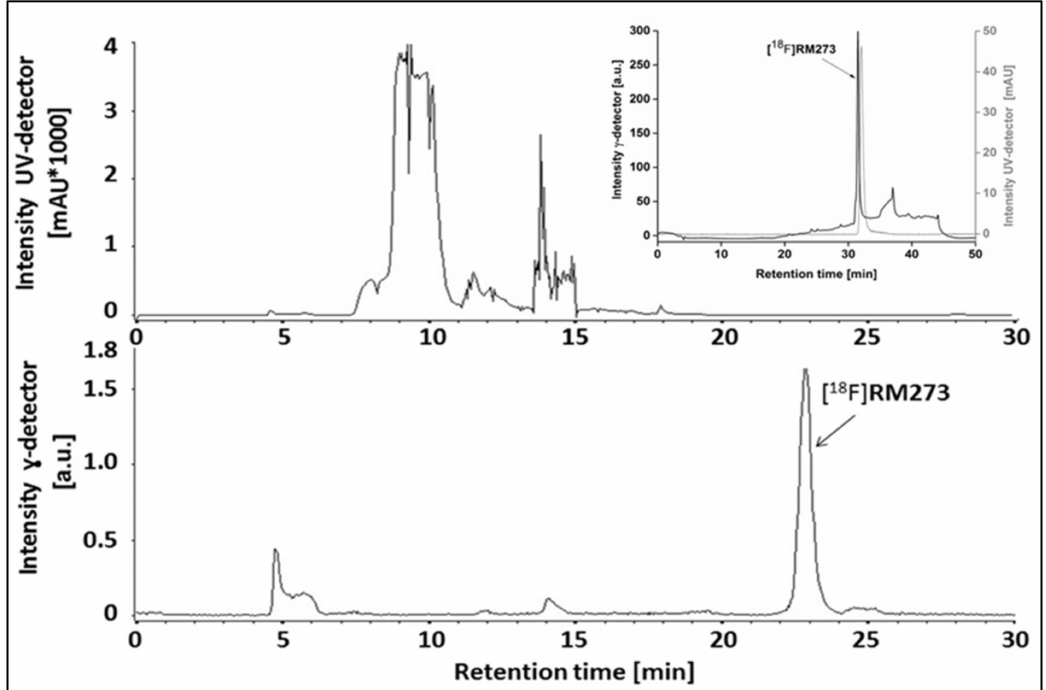
Figure 2. Representative radio- and UV-HPLC chromatograms of [ 18 F] RM273 isolated from the crude reaction mixture via semi-preparative HPLC (Reprosil-Pur C18-AQ column (250 × 10 mm, 5 µ m), 58% MeCN/20 mM NH 4 OAc aq. , flow: 2.2 mL/min), and, in the upper right corner, the radio- (black line) and UV- (gray line) HPLC chromatograms of the identity confirmation of [ 18 F] RM273 co-injected with the reference standard RM273 (Reprosil-Pur C18-AQ column (250 × 4.6 mm; 5 µ m); gradient (eluent A 10% MeCN/20 mM NH 4 OAc aq. ; eluent B 90% MeCN/20 mM NH 4 OAc aq. ): 0–10 min 100%